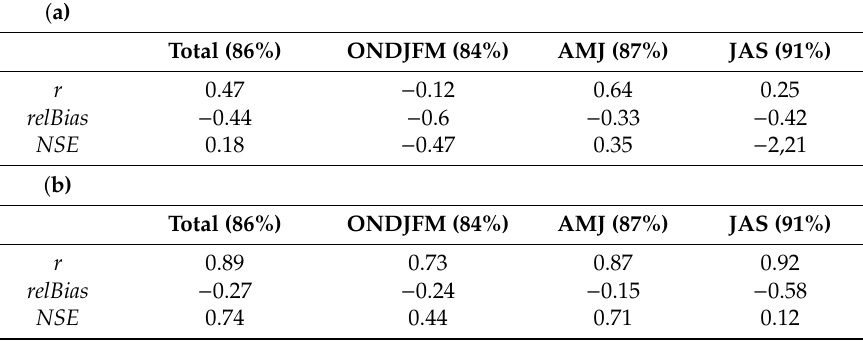
Table 3. Seasonal statistics for Lake Sherburne (sher) (panel a) and Lovewell Dam (lvks) (panel b). Rows represent statistical scores (from top to bottom): r , relBias and NSE . The columns represent the scores over each season: “total” refers to the total length of the retrospective time series, “ONDJFM” refers to the time-period from October to March, “AMJ” refers to the time-period from April to June, “JAS” refers to the time-period from July to September. The percentages in brackets next to each column represent the percentage observational data availability over the time period of